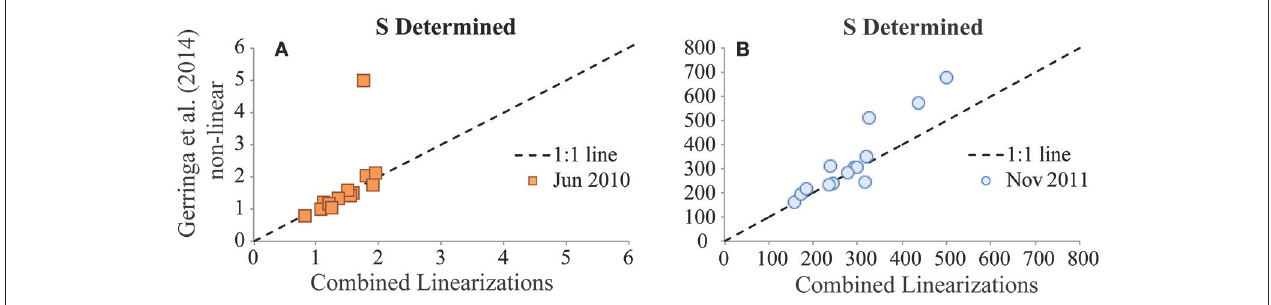
FIGURE 6 | Values of the sensitivity (S) parameter determined for the GA02 (June 2010) dataset ( A , units: nA nM − 1 ) and for the GA03 (Nov 2011) dataset ( B , units: nA nM − 1 ). S values determined from the Combined Linearization approach to data interpretation are plotted on the x-axes vs. the results from the Gerringa et al. (2014) non-linear data interpretation approach on the y-axes.